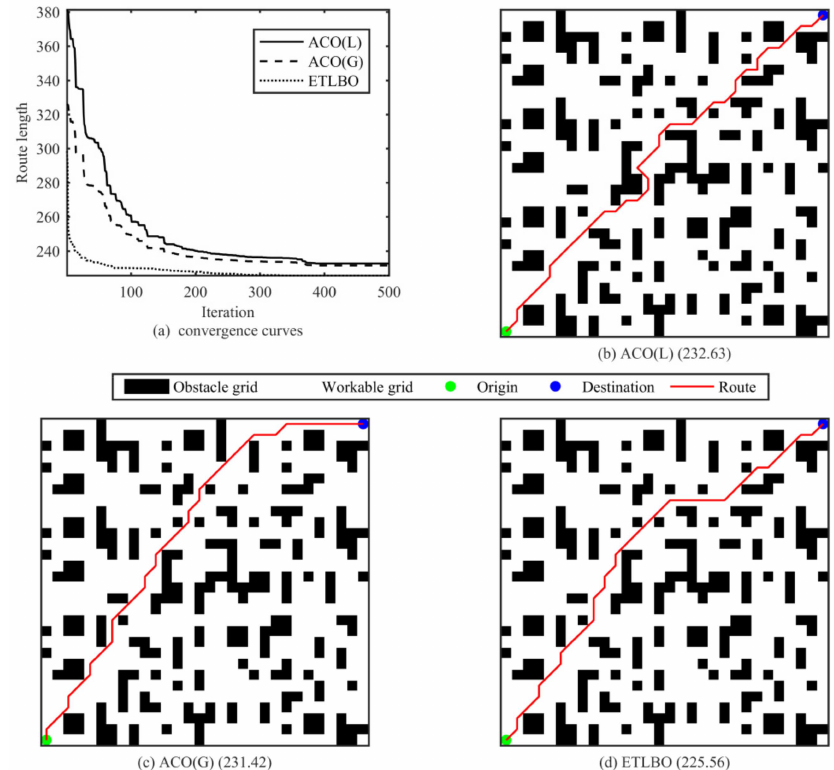
Figure 7. Best solution information of instance 30 × 30.